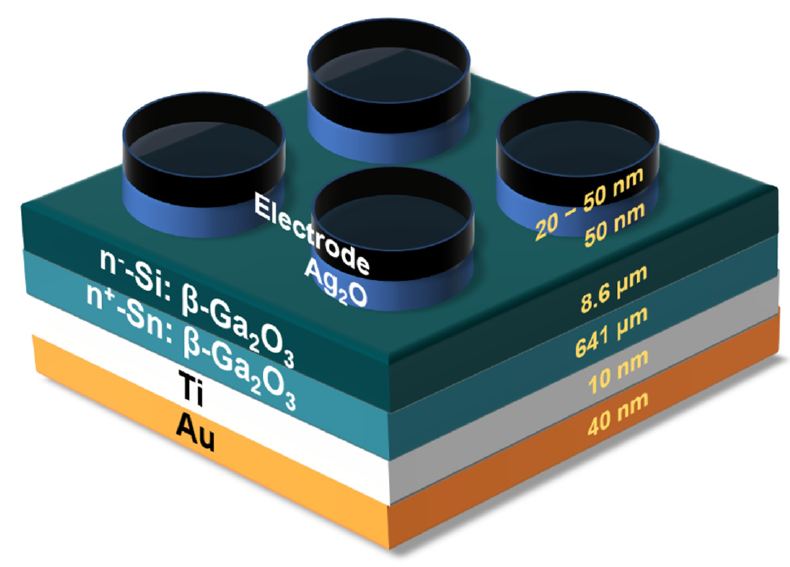
Scheme 2. Schematic illustration of the p-n junction photodetector. Table 3. Sputtering conditions of p-type Ag 2 O layer.